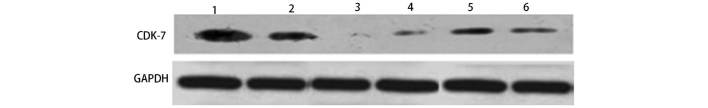
Western blotting analysis for CDK7, in cells treated with four siRNAs, a negative control and blank control groups. Lane 1, CDK7-1 siRNA; lane 2, CDK7-2 siRNA; lane 3, CDK7-423 siRNA; lane 4, CDK7-910 siRNA; lane 5, negative control; and lane 6, blank control. CDK7, cyclin-dependent kinase 7.